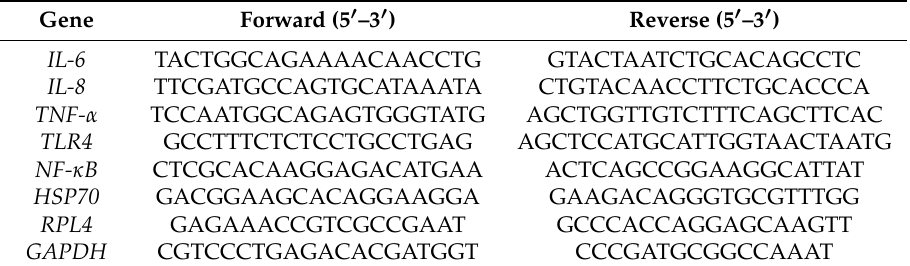
Table 7. Sequences of the primers used for quantitative RT-PCR